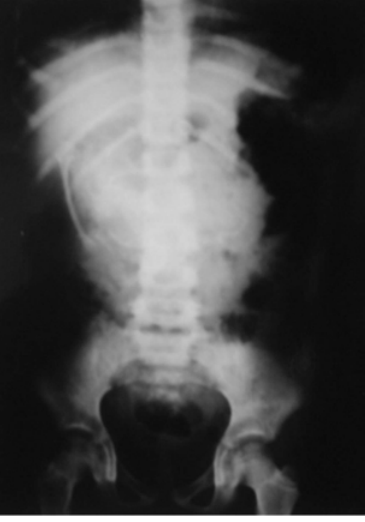
FIGURE 1. X-ray shows areas of calcification and long bone in right upper abdomen.